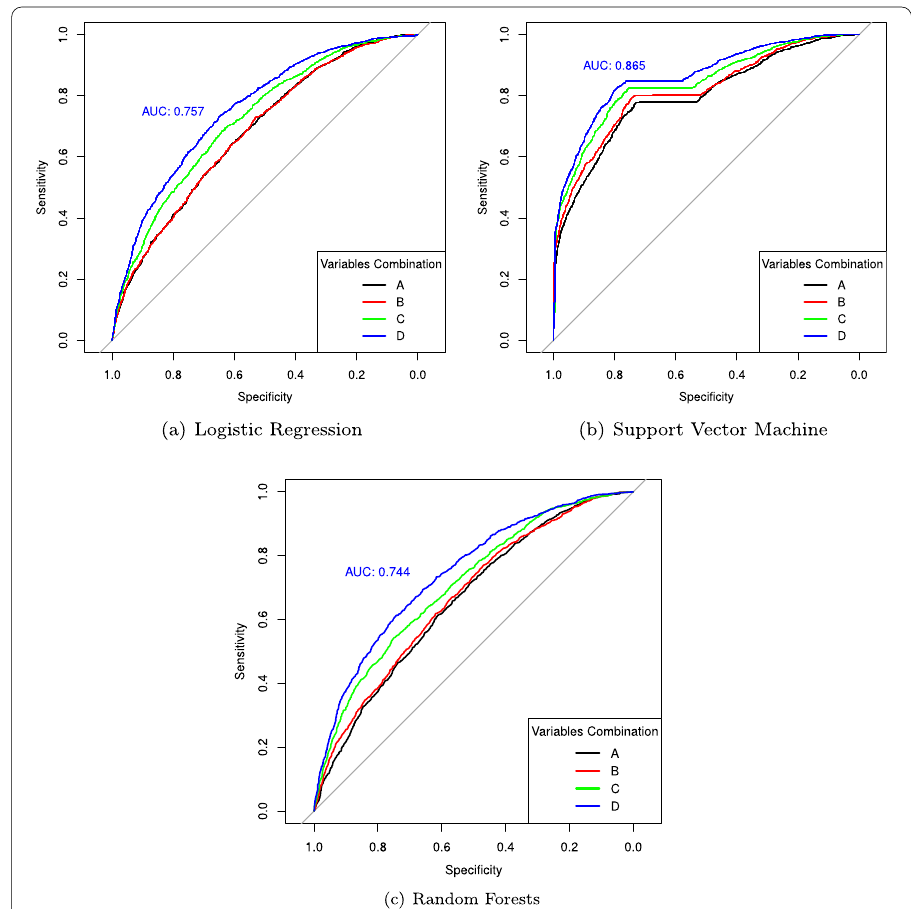
Fig. 10 ROC comparison of different predictive models